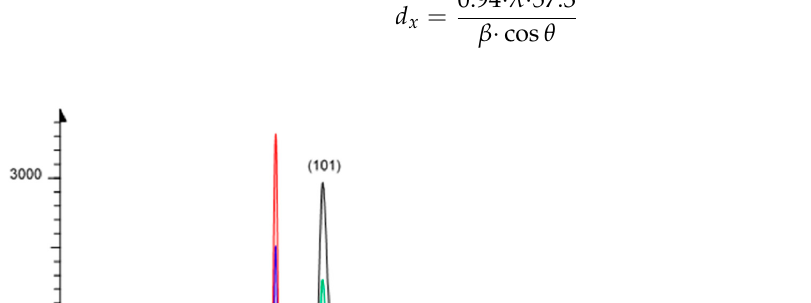
Figure 2. XRD patterns of NiTe 2 prepared mechanochemically after 1 h, 2 h, 4 h, 8 h, and 12 h milling time. Black and red vertical lines represent the precursors Ni and Te, respectively.